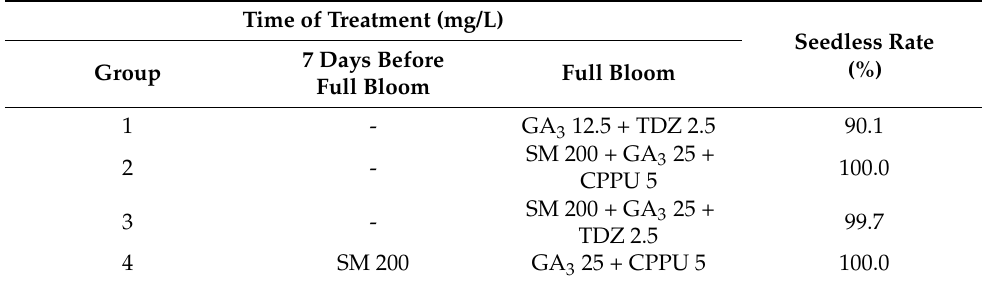
Table 1. Effect of streptomycin (SM), gibberellic acid 3 (GA 3 ), thidiazuron (TDZ), and forchlorfenuron (CPPU) application on the induction of seedlessness in the ‘Shine Muscat’ grape. Time of Treatment